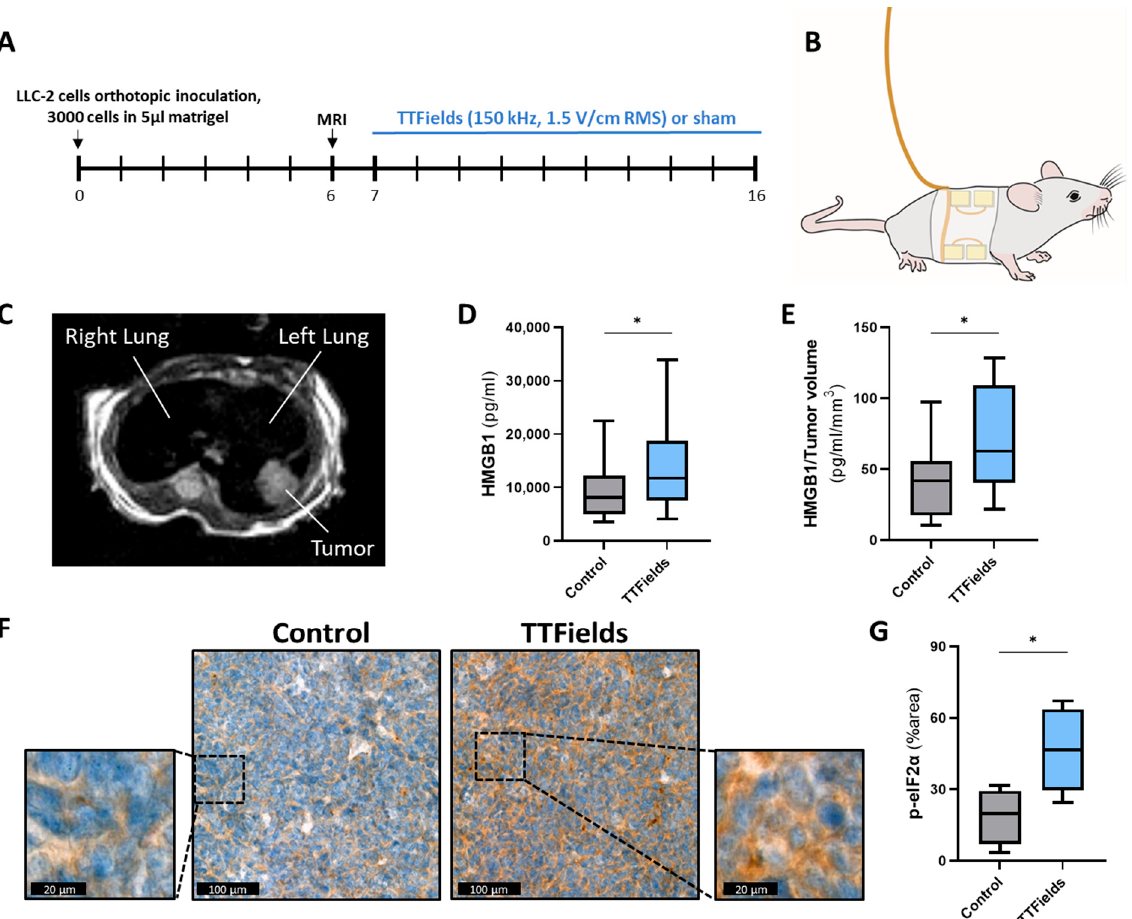
Figure 1. TTFields induced ICD in vivo. Mice were orthotopically inoculated with LLC-2 Lewis lung carcinoma cells, and TTFields or sham were delivered to the mice continuously for 10 days ( A ) via arrays placed symmetrically around their thorax ( B ). MRI was conducted at 6 days after tumor inoculation to verify the tumor was located within the lungs ( C ). At the end of treatment, circulating HMGB1 ( D , E ) and intratumoral p-eIF2 α (( F , G ) p-eIF2 α in brown staining, and hematoxylin in blue staining) levels were measured. Values are mean ± SD. * p < 0.05; Student’s t -test.